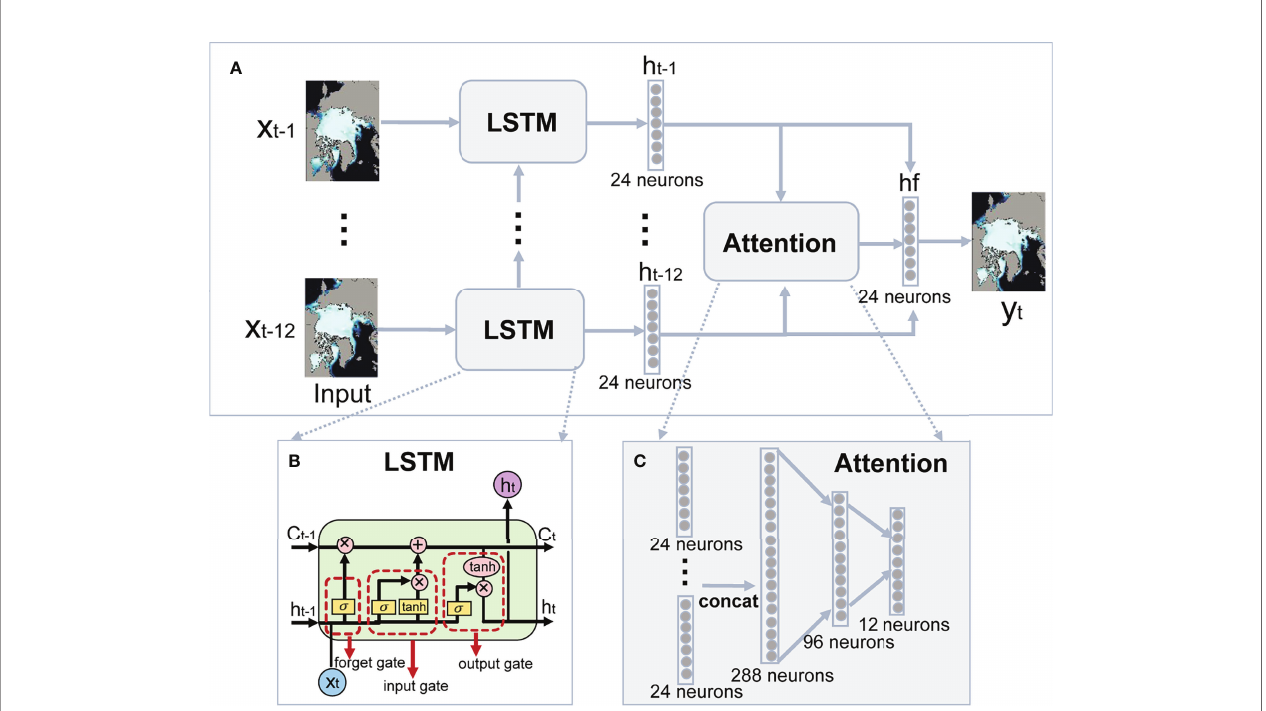
FIGURE 4 | The overall architecture of the attention-based LSTM with combination loss (A) and the details of a single LSTM cell (B) and the attention module (C) . In (A) , “ x ” is the input SIC, “ y ” is the forecasted SIC, “ h ” denotes hidden state of LSTM, “ hf ” is the fi nal hidden state processed by the attention module. In (C) , “ concat ” represents the concatenating of all the hidden states